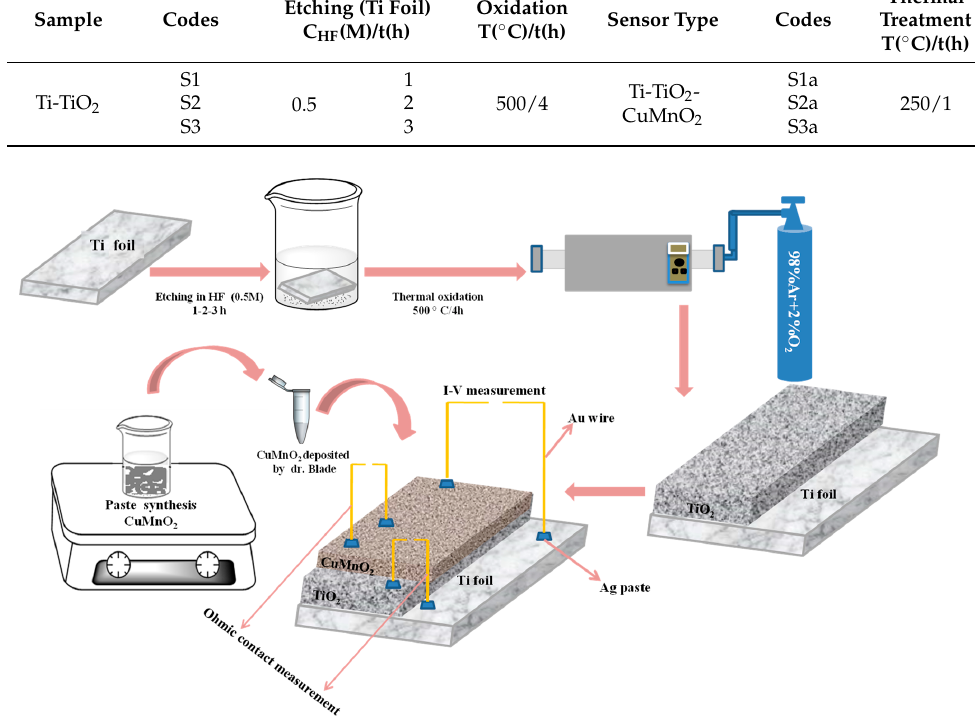
Figure 1. Fabrication process of the sensors.